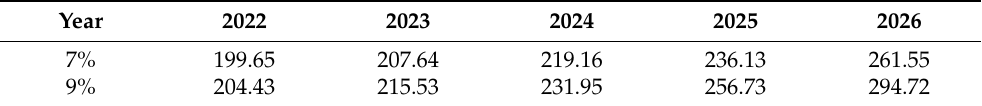
Table 18. Prediction result of water requirement with different growth rates of AVTI in Hebei Province.